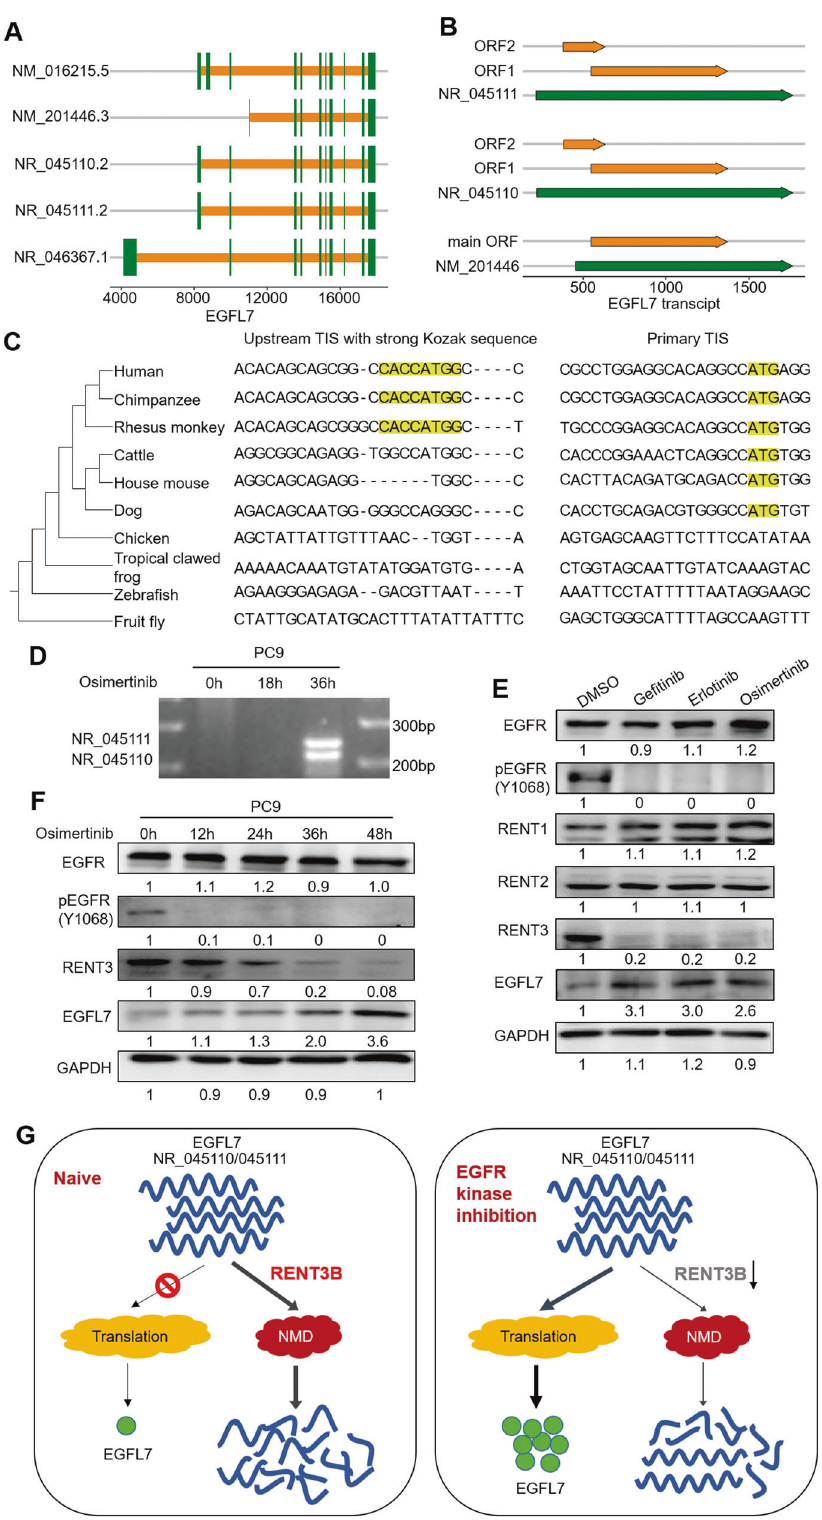
Fig. 4 Long-term inhibition of EGFR kinase leads to decreased decay of EGFL7 transcripts. A , B Schematic of EGFL7 transcripts and open reading frames (ORF) in certain transcripts. C Two small alignment regions corresponding to two translation initiation sites (TISs) of EGFL7 in ten species. The evolutionary tree obtained from NCBI Taxonomy database is presented on the left. D The electrophoresis presenting speci fi c EGFL7 transcript in PC9 cells treated with osimertinib for the indicated time points. E Western blot analysis showing the levels of EGFR, pEGFR, RNET1, RNET2, RNET3 and EGFL7 in response to the indicated EGFR kinase inhibitors. F Western blot analysis showing the level of EGFR, pEGFR, RNET3 and EGFL7 in PC9 cells treated with osimertinib for the indicated time points. GAPDH was used as a loading control. G Schematic of declined decay of EGFL7 transcripts in response to EGFR kinase inhibition.